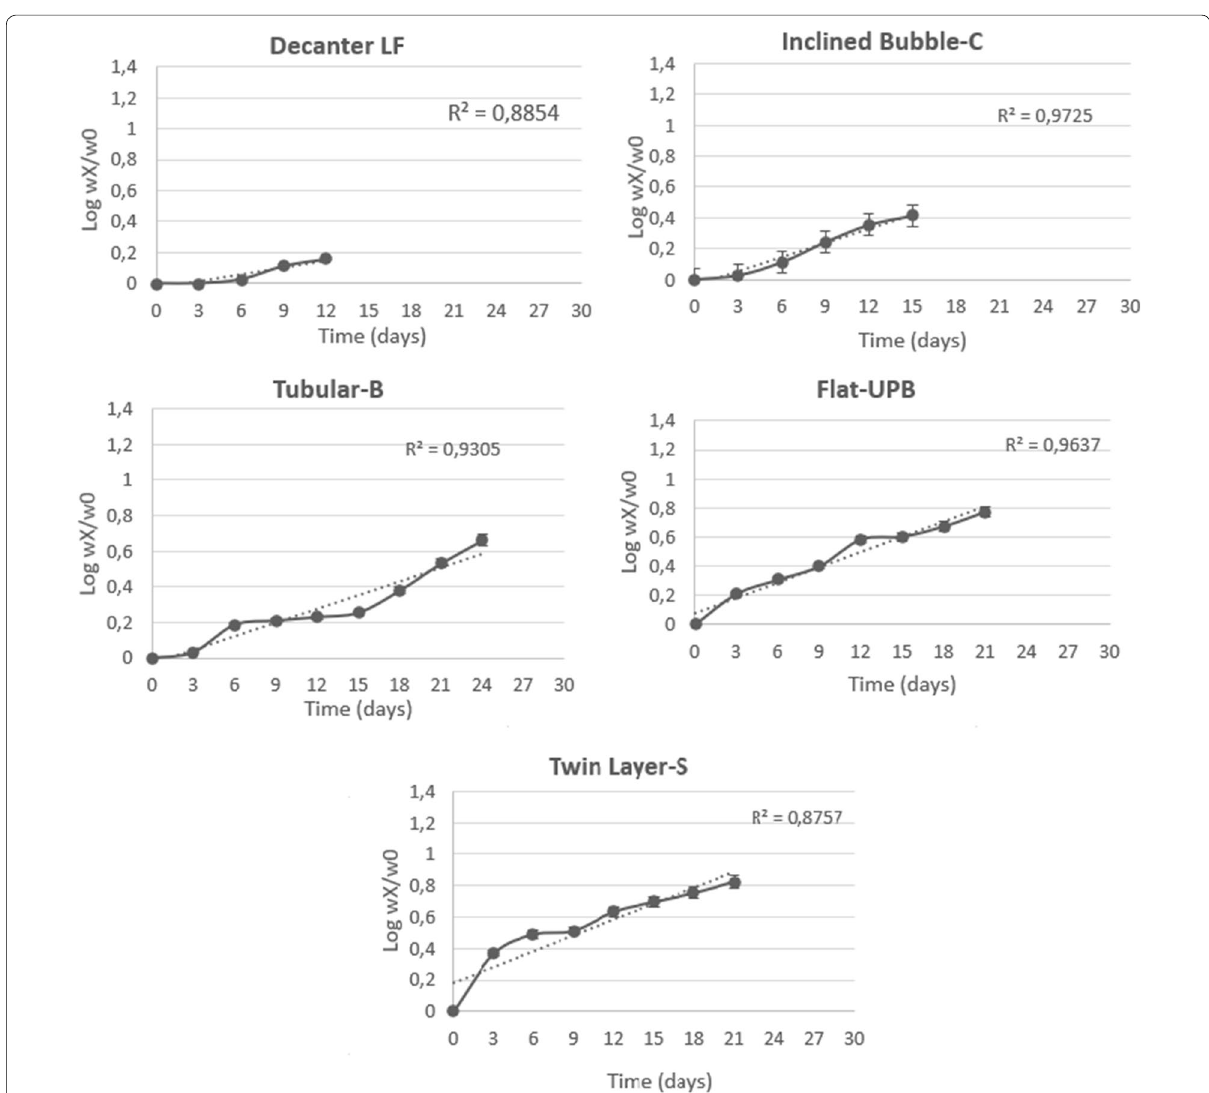
Fig. 3 Biomass trends and equation of the line and R 2 values in the different